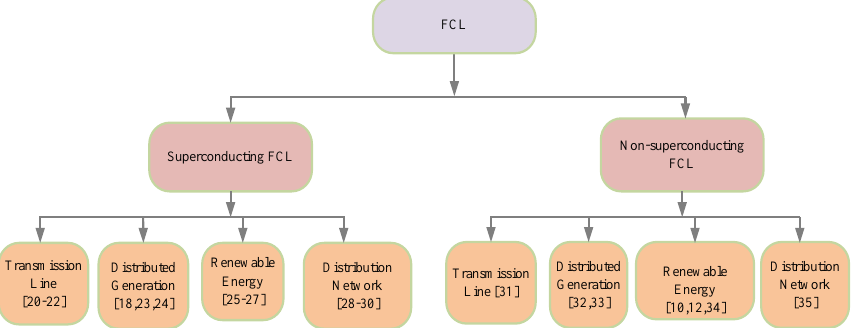
Figure 1. Superconducting and non-superconducting fault current limiters (FCLs) in different branches of power system.